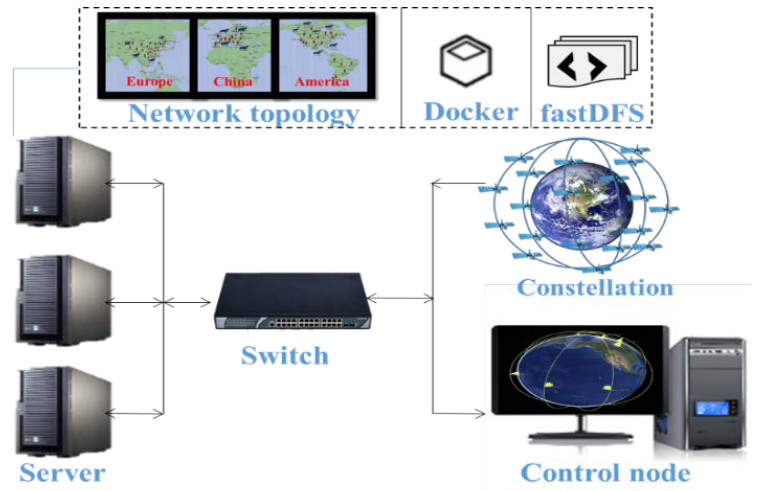
Figure 6. Simulation